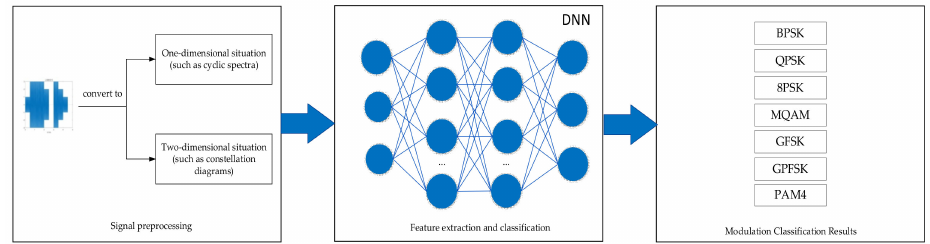
Figure 5. Deep learning-based modulation recognition model.